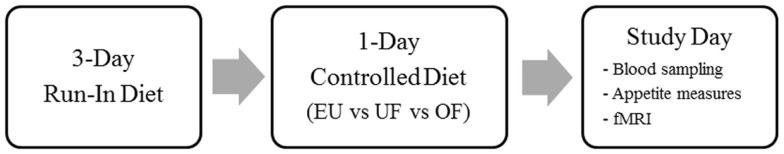
Study design. Subjects were studied during three conditions, eucaloric (EU), underfeeding (UF), and overfeeding (OF) as shown.